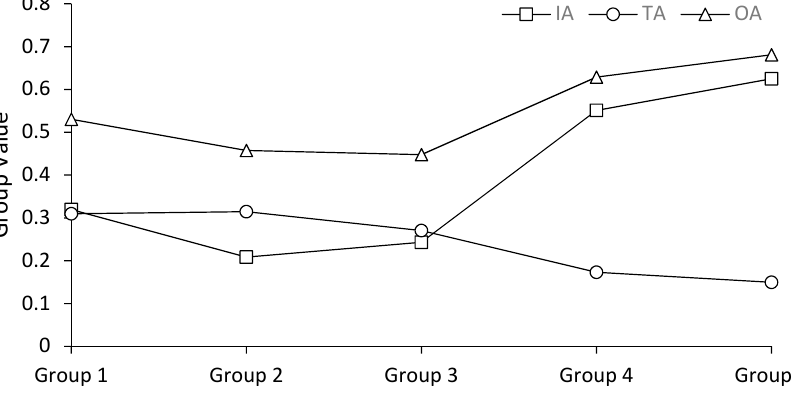
Figure 7. Changes in IHA groups under IA , TA , and OA .